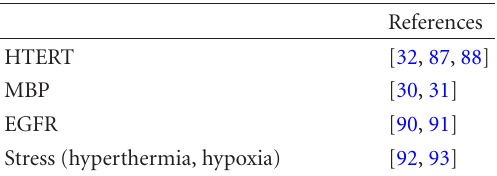
Table 3. Delivery systems. Table 4.